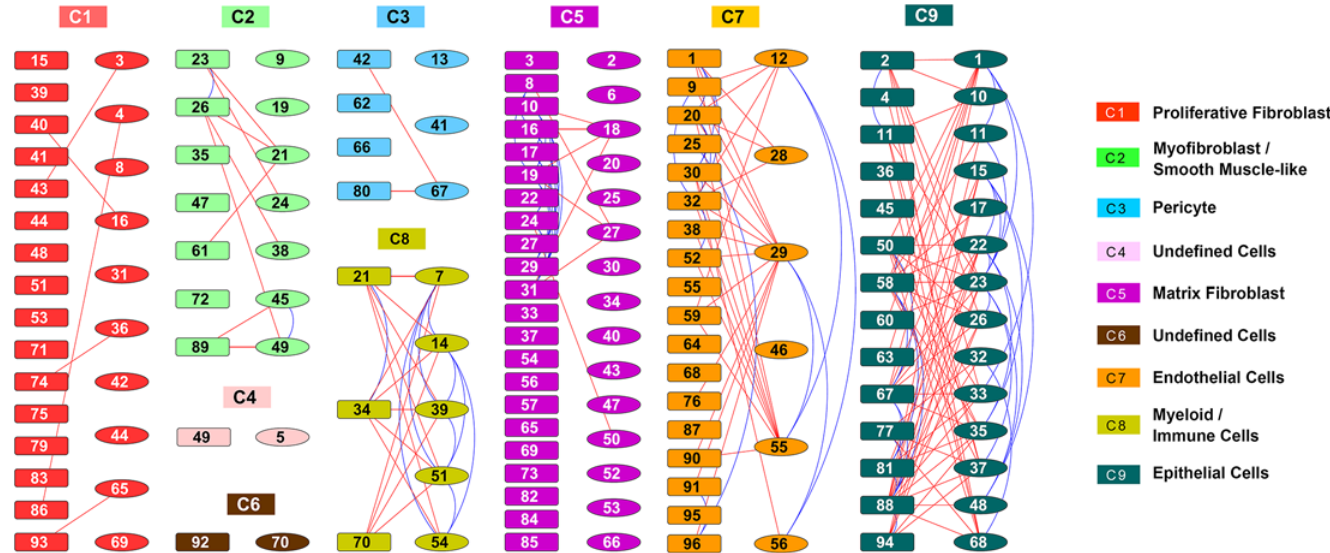
Fig 2. Identification of Major Lung Cell Types. Cells (n = 148) from two sample preparations from fetal mouse lung at E16.5 were assigned into 9 clusters via hierarchical clustering using average linkage and centered Pearson ’ s correlation. Each color represents a distinct cell cluster, labeled as C1-C9. The rectangles represent single lung cells from the first preparation and the ellipses consist of single cells from a second independent preparation. Connection lines indicate the z-score correlation between the two cells > = 0.05. The blue lines connect cells within the same preparation, while the red lines connect cells across